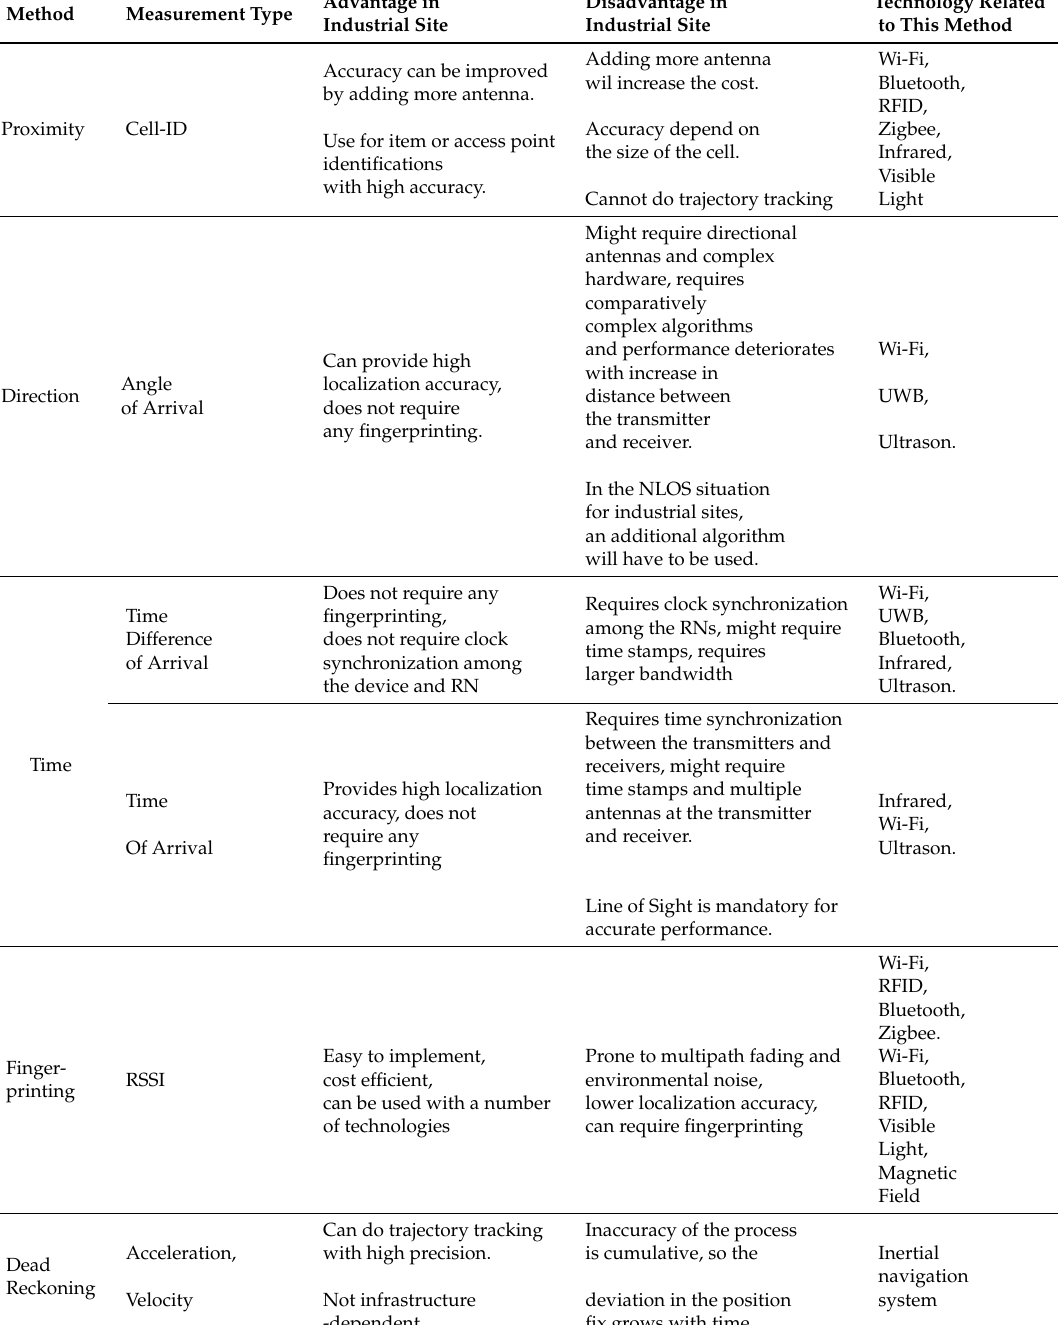
Table 1. Indoor localization comparison: techniques and